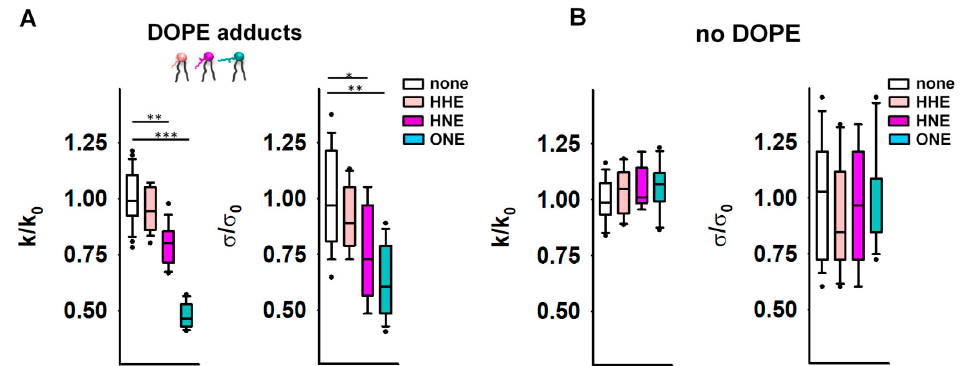
Figure 2. Elastic properties of the lipid bilayer membrane in the presence of reactive aldehydes (RAs). ( A , B ) Relative bending rigidity k/k 0 and relative lateral tension σ / σ 0 for lipid membranes composed of DOPC:DOPE:CL 45:45:10 in ( A ) and DOPC:CL 90:10 in ( B ), incubated with the RAs 4-hydroxy-2-hexenal (HHE), 4-hydroxy-2-nonenal (HNE), and 4-oxo-2-nonenal (ONE). k 0 and σ 0 are bending modulus and lateral tension in the absence of RAs, respectively. RAs were added in a concentration range of 0.5–0.7 mM. Buffer composition: 100 mM KCl, 10 mM HEPES, 1 mM EDTA pH = 7.0, T = 295 K. Data points represent mean and standard deviation from more than 10 independent experiments. * p < 0.05; ** p < 0.01; *** p < 0.001, t -test.